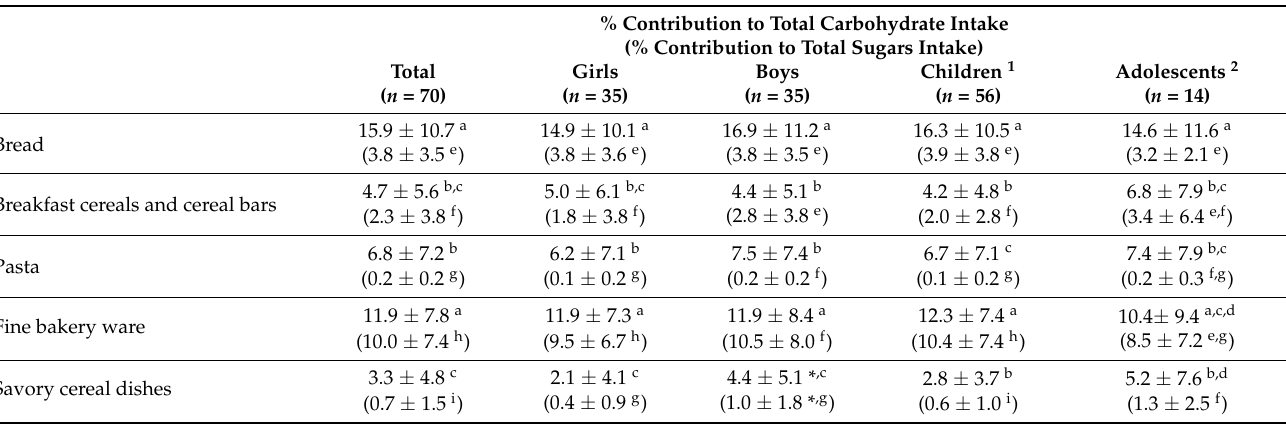
Table 6. Contribution of the different types of gluten-free products to the daily carbohydrate and sugar intakes in Spanish children and adolescents, both genders, with celiac